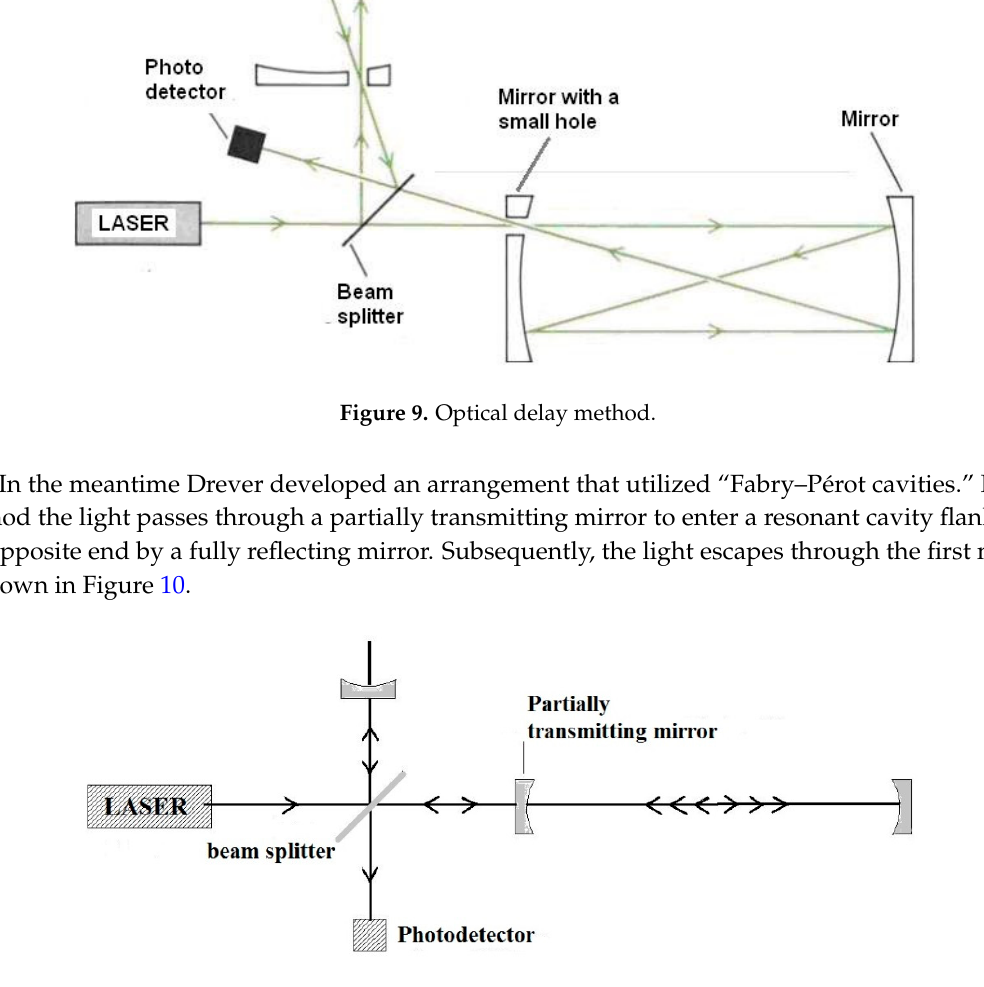
Figure 10. Fabry–Pérot method.